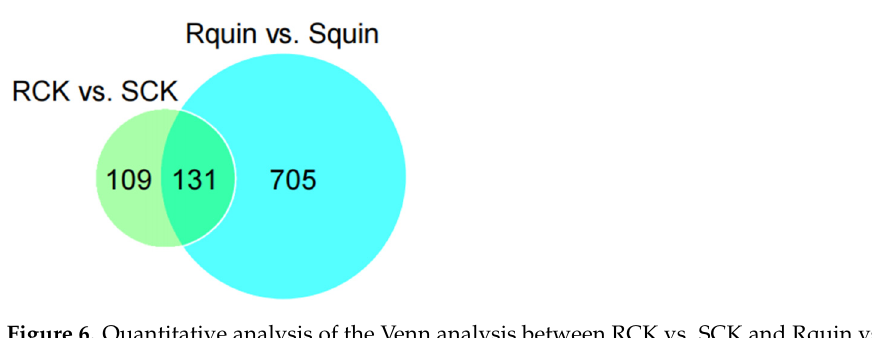
Figure 6. Quantitative analysis of the Venn analysis between RCK vs. SCK and Rquin vs. Squin.